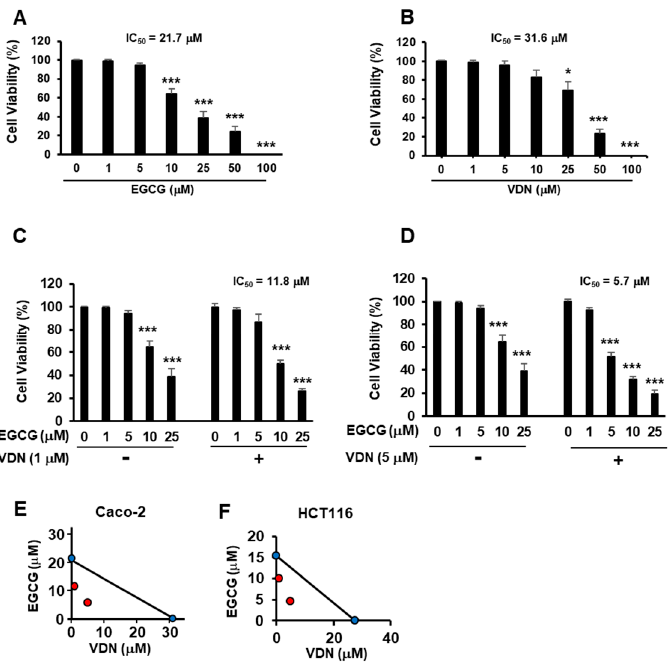
Figure 1. Combination of EGCG and VDN synergistically induces cell death in colorectal adenocarci- noma. ( A – D ) Viability of Caco-2 cells cultured with EGCG and the PDE5 inhibitor vardenafil (VDN) for 96 h. ( E , F ) Synergistic effects of EGCG and VDN measured using the isobologram analyses. Data are presented as mean ± SEM ( n = 3); * p < 0.05, *** p <